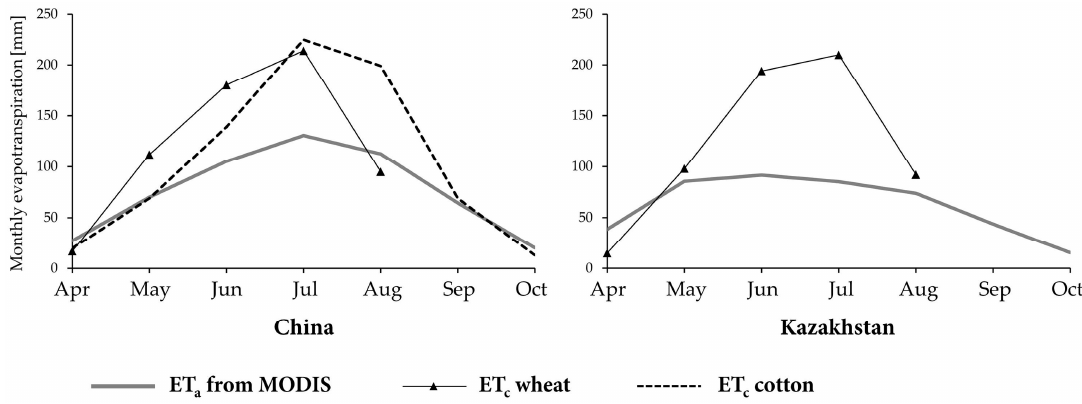
Figure 4. Monthly actual evapotranspiration, ET a , from MODIS (average from 2000, 2005, 2009, 2010, and 2014) for agricultural land along the Ili River in China and Kazakhstan, and monthly ET c for wheat and cotton.